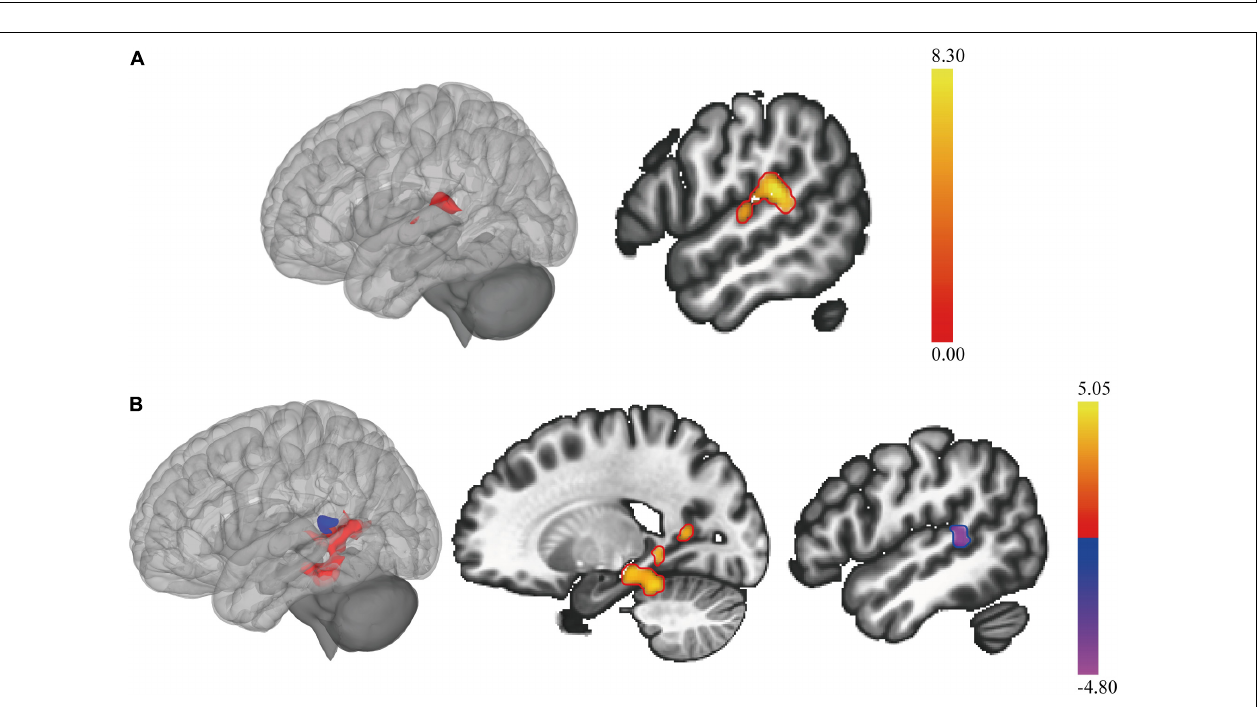
FIGURE 2 | The fALFF, ReHo and DC changes in patients with NPSLE and non-NPSLE. The colored bar indicates the statistical T distribution between groups.